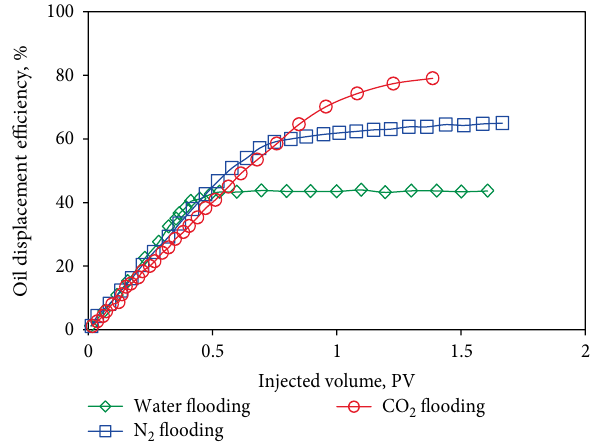
Figure 22: The oil displacement efficiency of water, CO